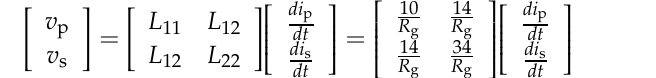
Figure 4. T-model of the transformer T 2 .